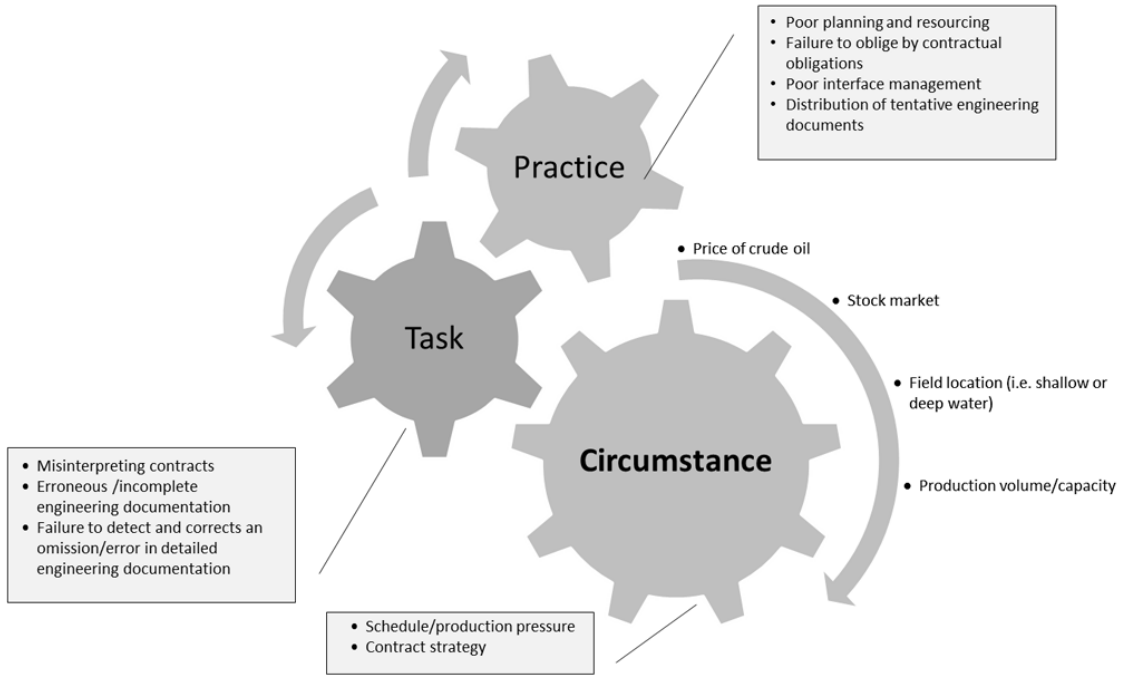
Fig. 4. Interrelationship between